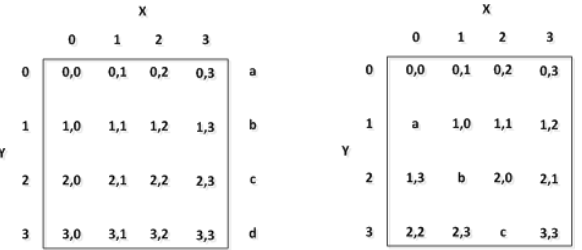
Figure 1: Shared memory tile column padding to carry out the permutation on the data